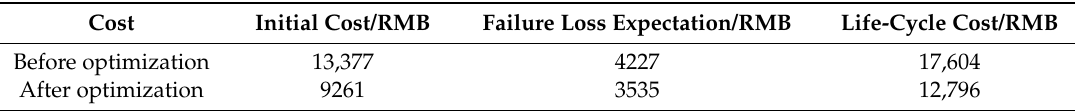
Figure 7. The optimization result of life-cycle cost. Table 5. A comparison of the costs before and after optimization.